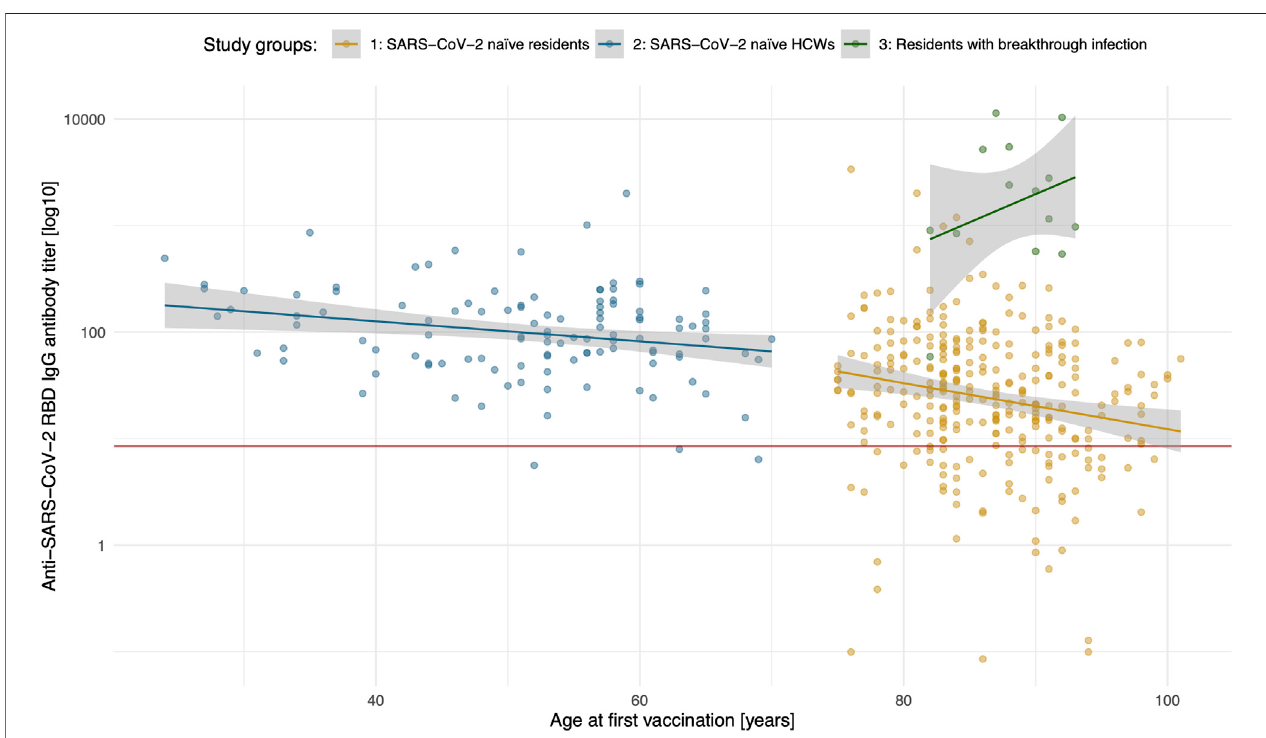
FIGURE1| Anti-SARS-CoV-2RBDIgGtiter(logarithmic)bystudyparticipants ’ age.Group1(orange),group2(blue),group3(green)aredepicted.Plottedwithinis thelinearregression(linesincoloursoftherespectivestudygroups)withthestandarderror(greyareas,95%CI).Theredlinedisplaysthecut-offanti-SARS-CoV-2spike IgG antibody concentration of 8.52 BAU/ml, which is considered a positive test result (borderline: 7.10 – 8.51 BAU/ml).